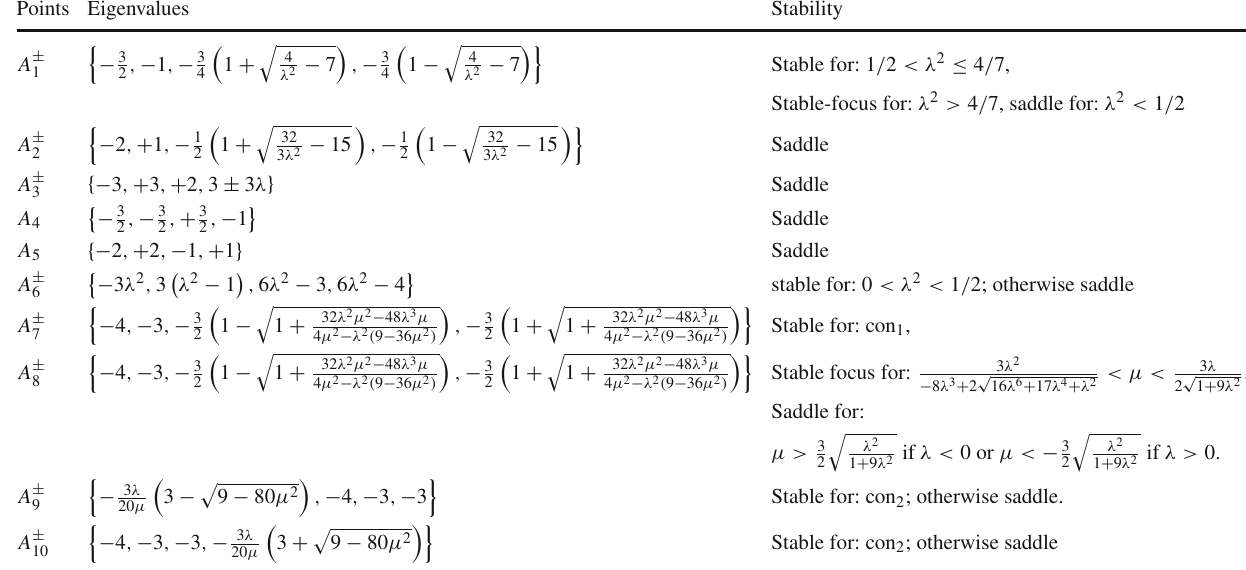
Table 2 The eigenvalues and the stability analyses of fixed points the system Eqs. (34)–(37) Points Eigenvalues